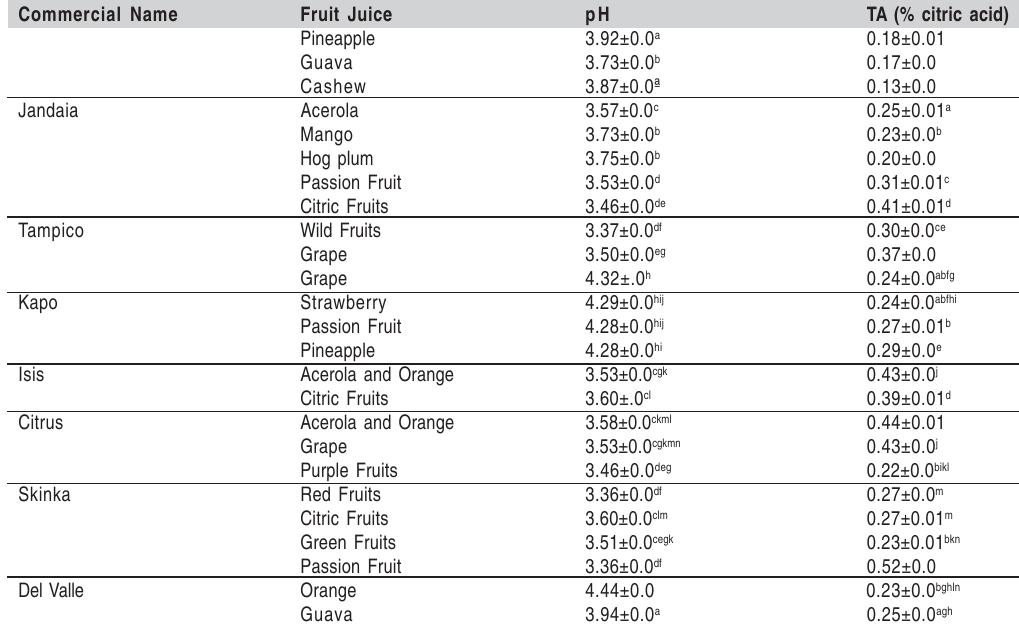
Table 2. Distribution of the fruit juices according to the mean values for endogenous pH and titratable acidity